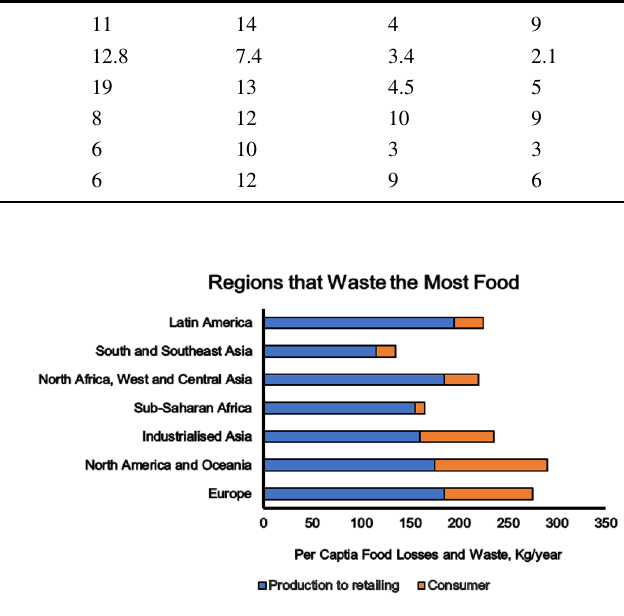
by material in the Arabian Gulf Countries (Al-Maaded et al.